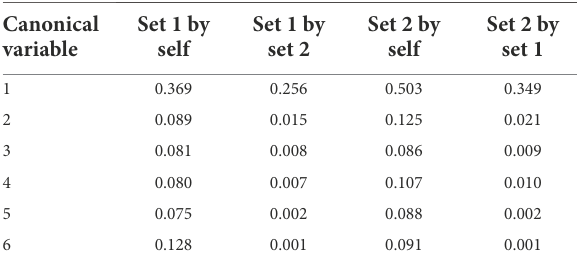
TABLE 12 Redundancy analysis